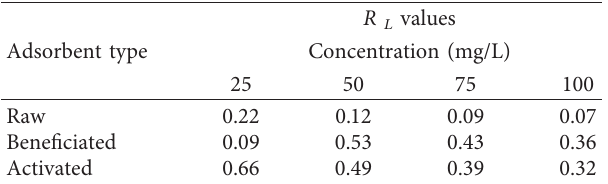
Table 3: Dimensionless constant separation factor ( R different adsorbents at different initial